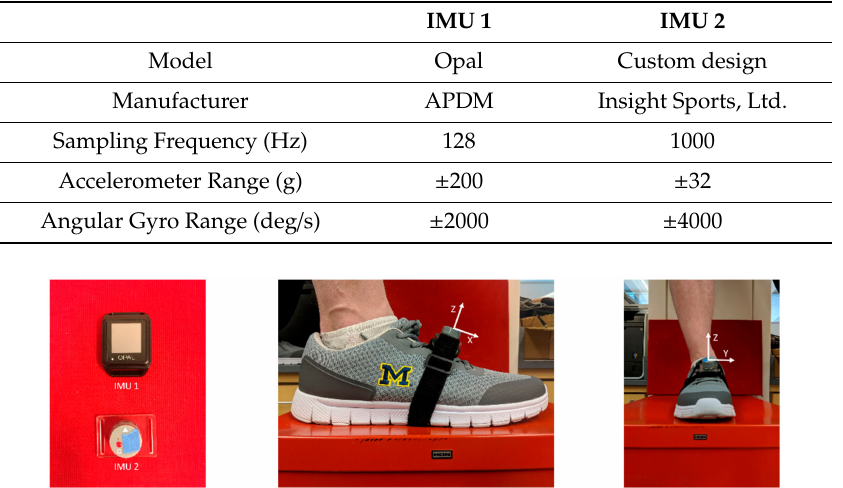
Table 1. Specifications for IMU 1 and IMU 2.